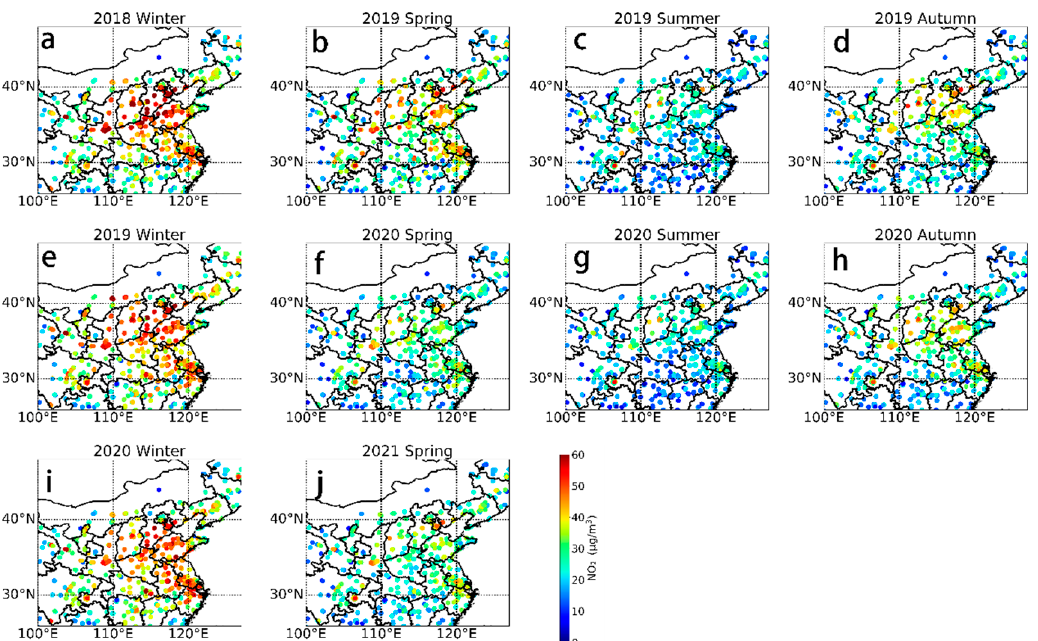
Figure 5. Seasonal average distribution of the NO 2 concentrations at state-controlled sites in selected cities in China. ( a ) 2018 winter, ( b ) 2019 spring, ( c ) 2019 summer, ( d ) 2019 autumn, ( e ) 2019 winter,